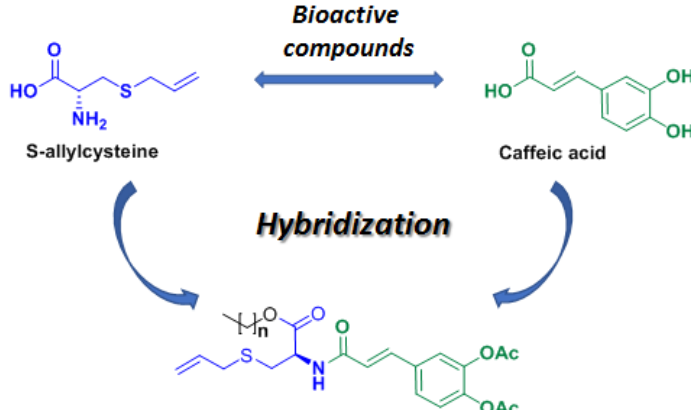
FIGURE 3 - Design of S -allyl cysteine-ester-caffeic acid amide hybrids as antiprotozoal